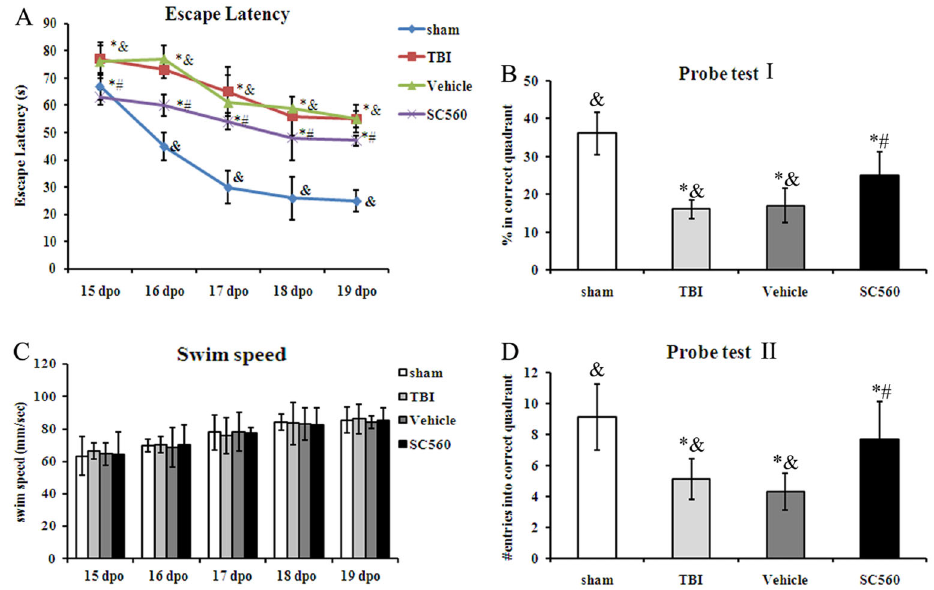
Figure 3. Spatial learning of mice evaluated by the Morris water maze. A , Traumatic brain injury (TBI) mice performed poorly, taking significantly more time to learn the position of the hidden platform compared with the sham group (P , 0.05). After administration with SC560, TBI mice had significant learning improvement on all 5 days of the test (SC560 group vs vehicle group, P , 0.05). Treatment with SC560 also compensated the defects in both the percent (Probe test I) and the number of entries (Probe test II) into the correct quadrant caused by TBI ( B , D ). Moreover, there were no differences in swim speed between sham and any of the injured groups (P . 0.05, C ). The behavior of vehicle-treated TBI mice was similar to that of TBI mice (P . 0.05). Data are reported as means±SD (n=8). dpo: days post operation. & P , 0.05, compared to SC560-treated group; *P , 0.05, compared to sham group; # P , 0.05, compared to vehicle-treated group (repeated-measures ANOVA with post hoc analyses performed after any significant main